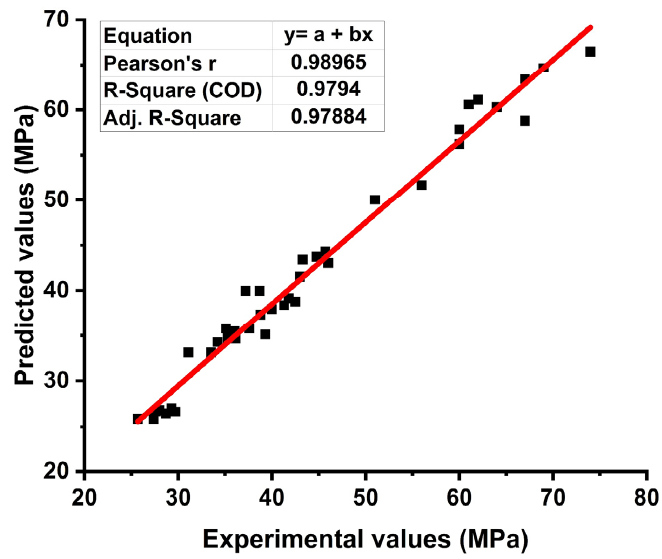
Figure 8. Regression analysis of testing set of MEP.